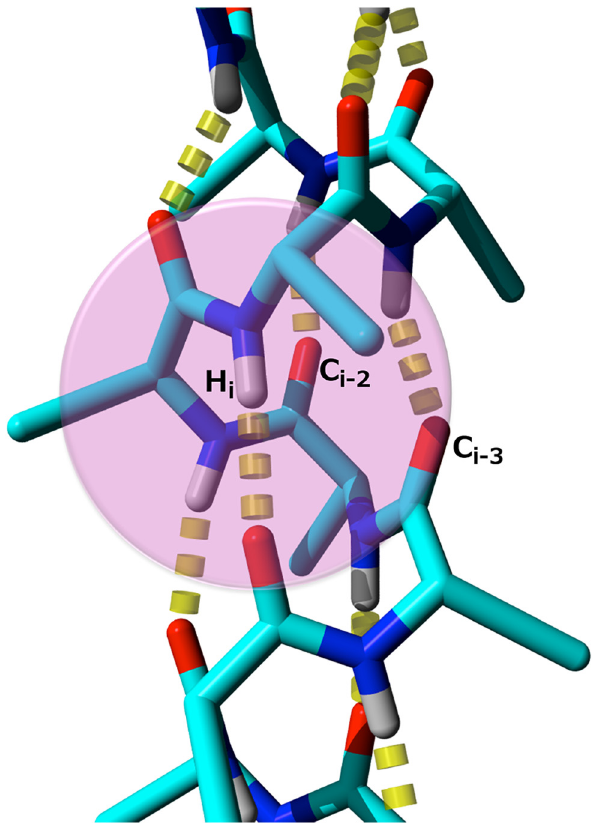
Fig 8. Illustration of the repulsion between C' and H atoms introduced by the curvature term in the CamTube model. The C' and H atoms belong to the α -helix and are 2 and 3 residues apart in the sequence.